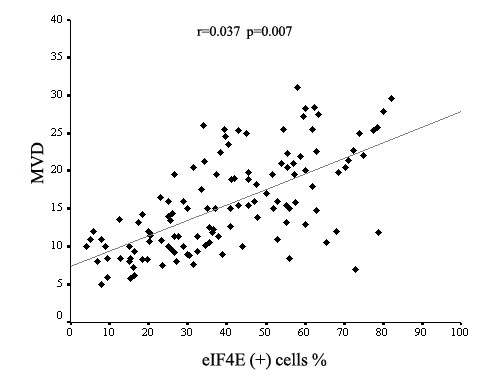
Linear regression analysis of the percentage of eIF4E positively stained cells with MVD.